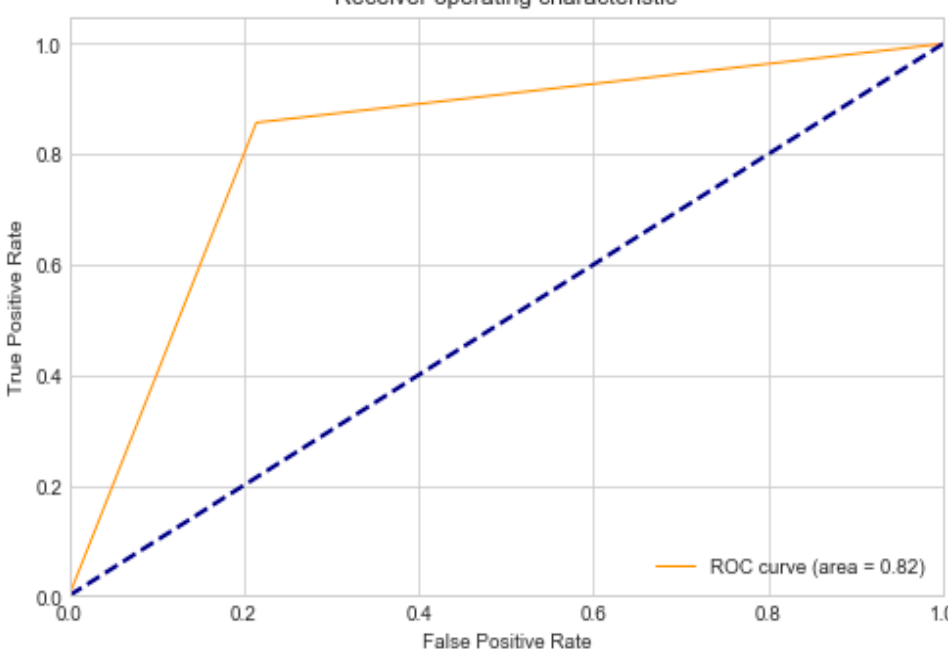
Figure 8. ROC curve comparing the True Positive Rate and False Positive Rate with the value of 0.82. Figure 9 depicts the training loss and validation loss after 20 epochs, whereas Figure 10 depicts the training and validation accuracy after 20